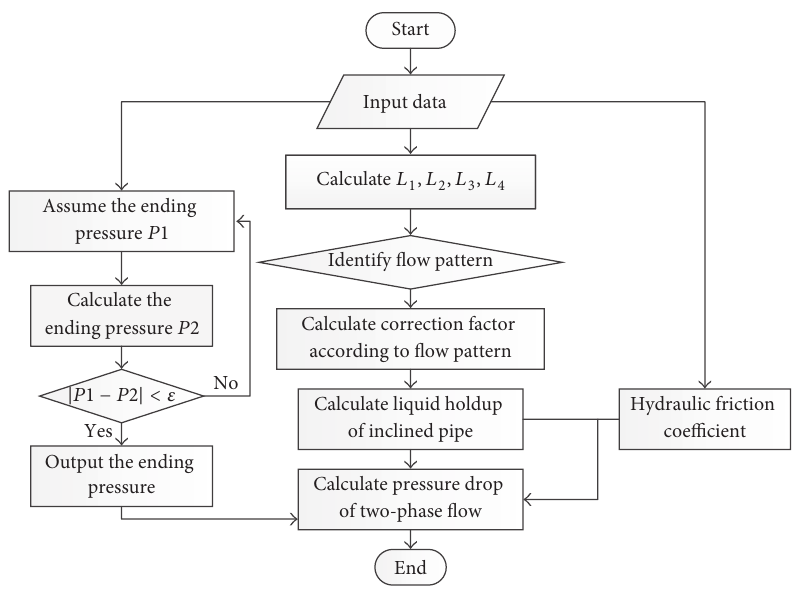
Figure 16: The program chart of BB